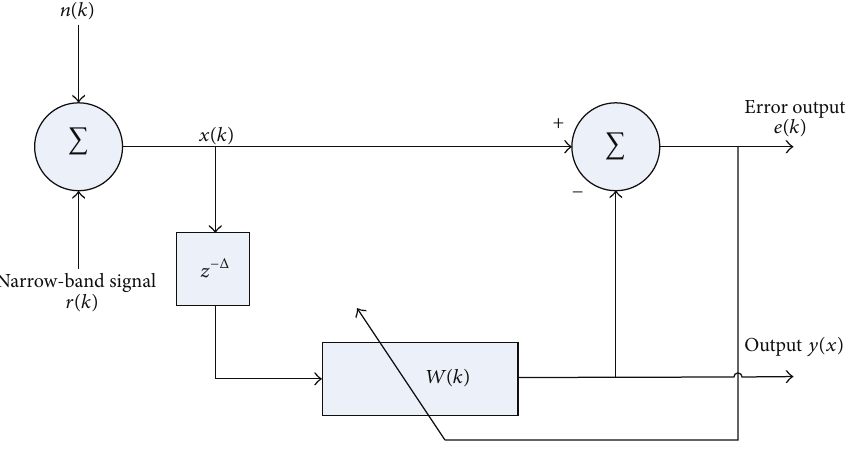
Figure 2: Basic structure of